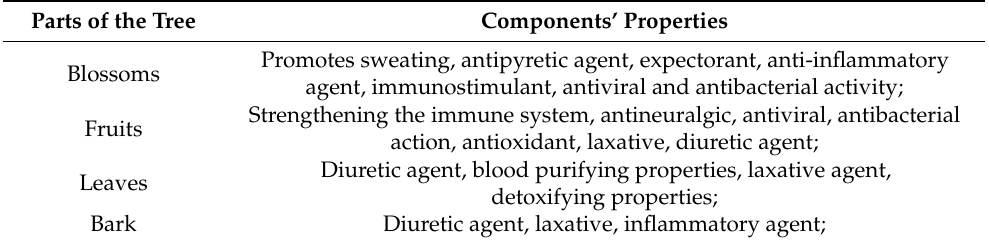
Table 1. Healing properties of Sambucus nigra